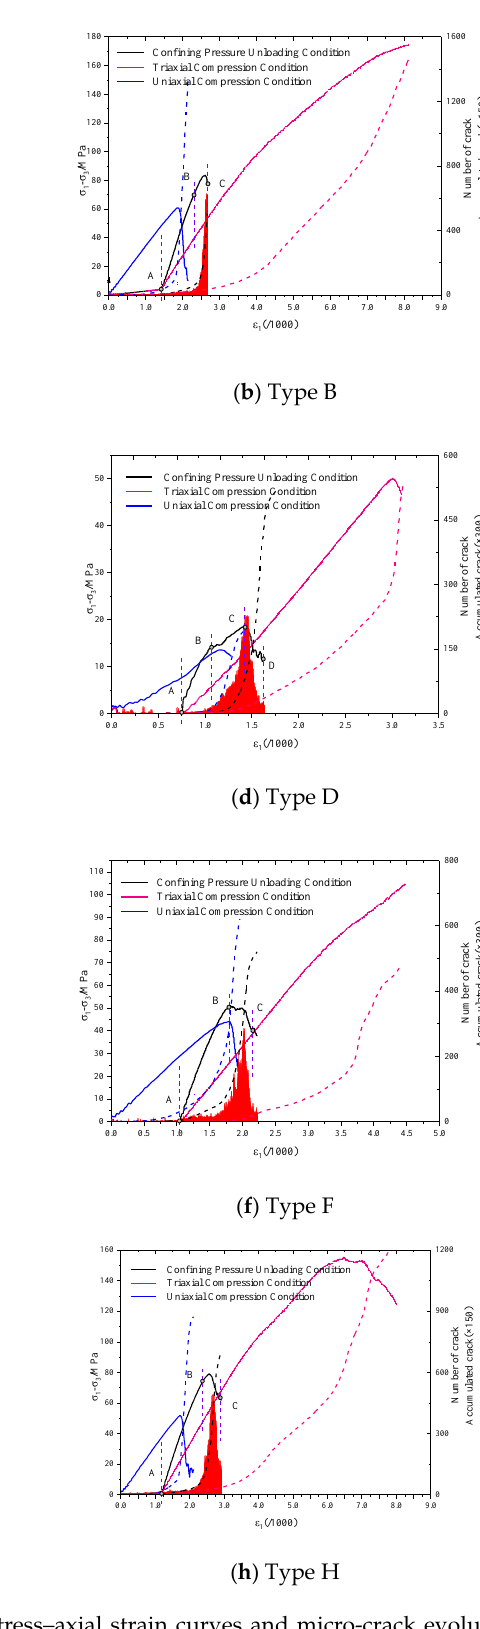
Figure 10. Numerically-predicted deviatoric stress–axial strain curves and micro-crack evolution curves of the pre-fissured marble specimens under loading and unloading conditions. The deviator stress–axial strain curves and micro-crack evolution curves of the Type A to Type D pre-fissured marble specimens are recorded in Figure 10. It can be seen that the pack stress of each